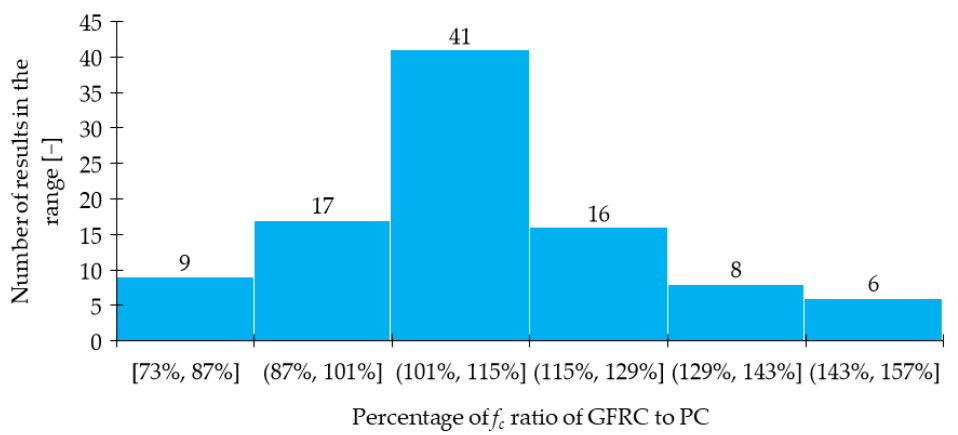
Figure 8. Histogram of f c ratio of GFRC to PC for the studies reviewed in Table 4.